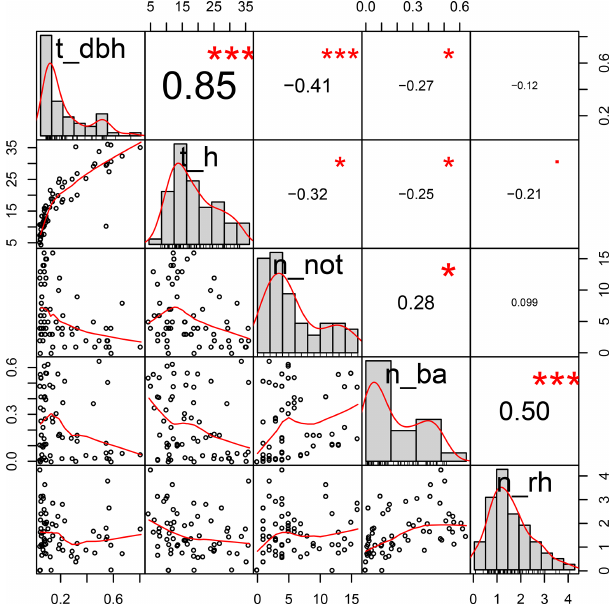
Figure A2. Distributions and correlations of variables included as fixed effects in the linear mixed effect models of individual tree stemflow. “t_dbh” refers to the tree DBH; “t_h” is the tree height; “n_not” is the number of trees in the neighbourhood; “n_ba” is the neighbourhood basal area; “n_rh” is the neighbourhood relative height; DBH is the diameter at breast height.